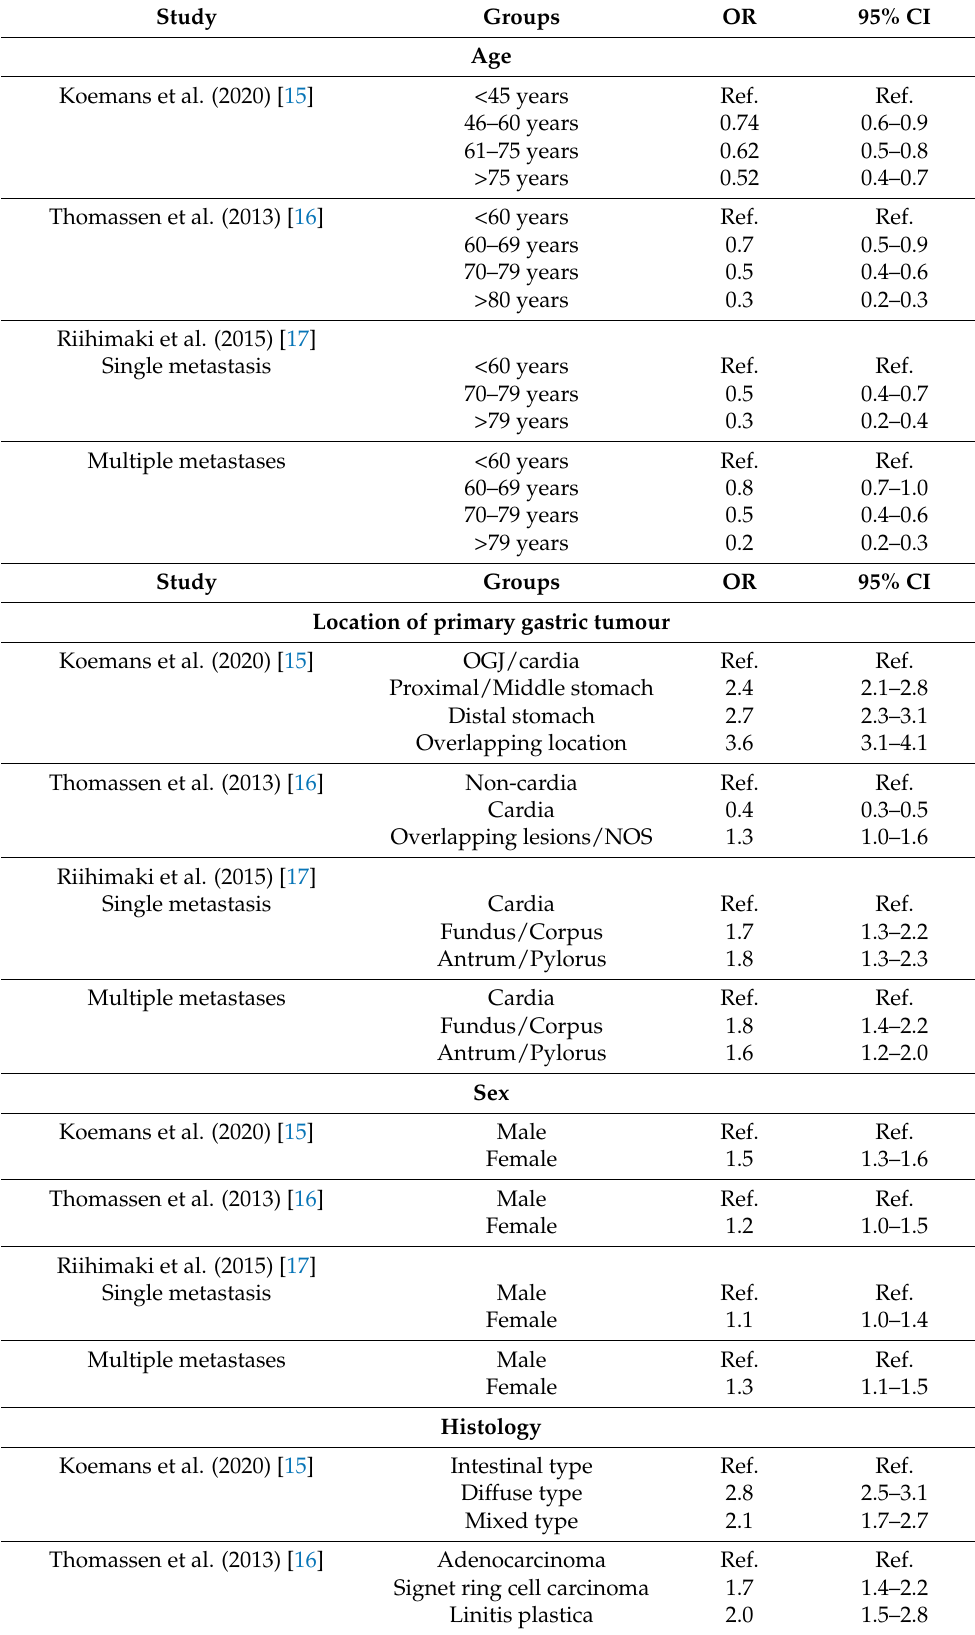
Table 3. Risk factors for synchronous gastric peritoneal